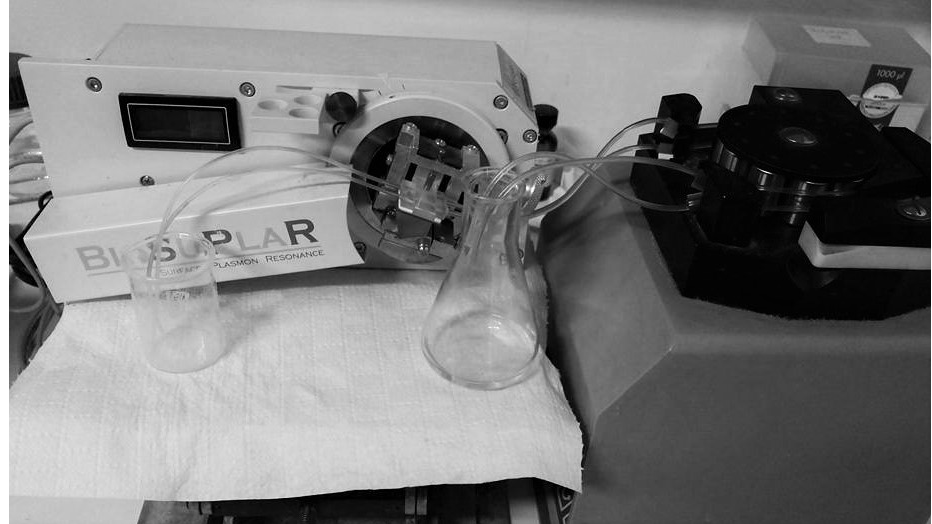
Figure 1. Measurement instrument used for Surface Plasmon Resonance (SPR) operating in flow mode.